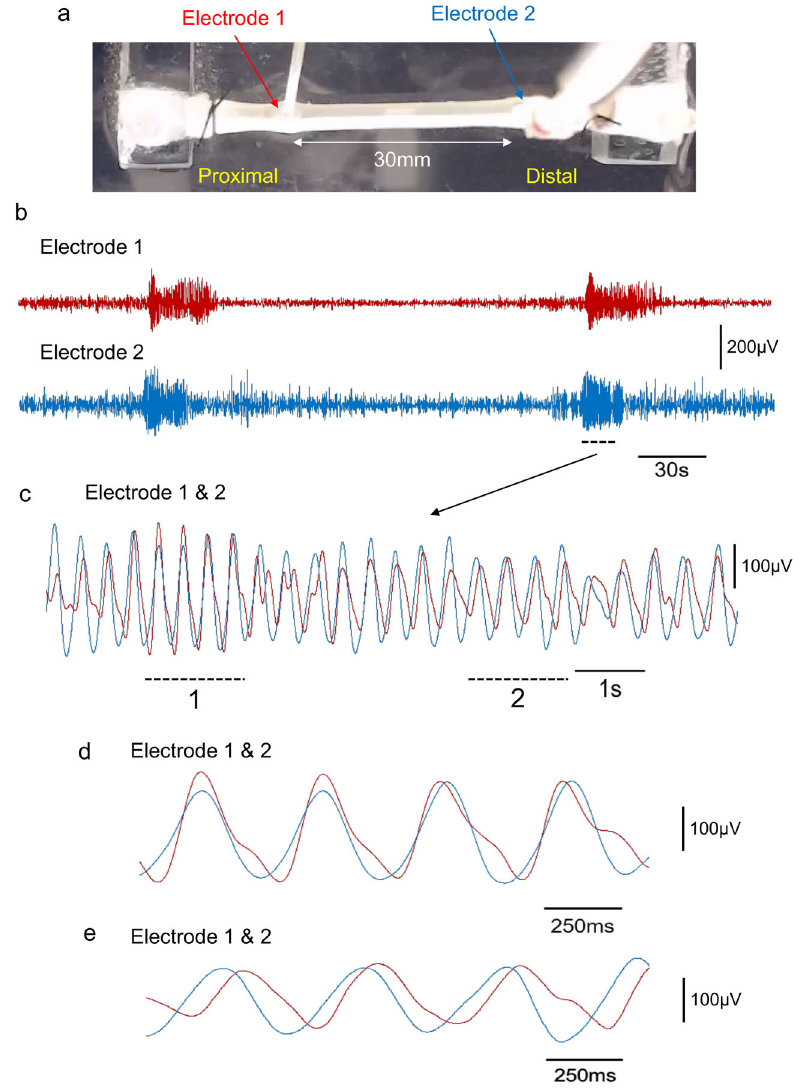
Fig. 5 Coordinated electrical activities in colonic smooth muscle during maintained colonic distension with a metal rod of uniform diameter inserted through the lumen. a Photomicrograph of the preparation of mouse colon with metal rod (inner diameter 2.41 mm through the lumen. The two electrodes are shown separated by 30 mm, one in the proximal-mid colon, the other in the distal colon. b shows simultaneous electrical recordings from the proximal and distal colon in the presence of nicardipine, where a coordinated burst of EJPs discharges at both electrodes. The periods represented by the bars labelled 1 and 2 are shown on expanded scale in c and e , respectively. d shows high temporal synchrony between EJPs, while a few seconds later in e , the EJPs are phase shifted by about 100